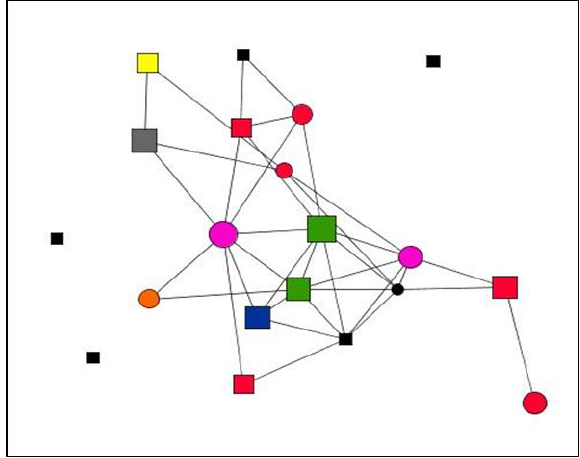
Figure 4. Graph Case 26. Man, 48 years old, 1 year with chronic pain.